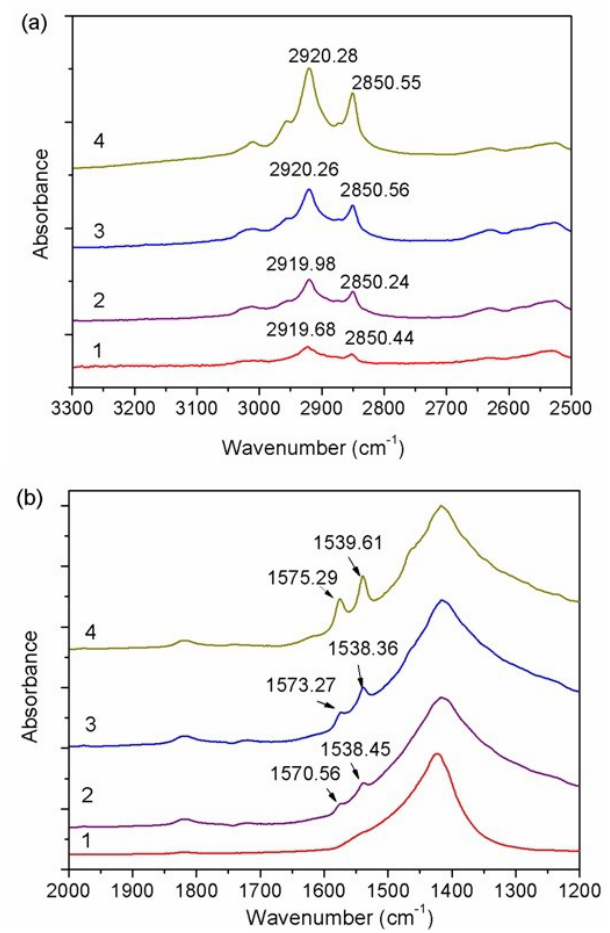
Figure 10. FTIR spectra ( a ) 3300–2500 cm −1 ; ( b ) 2000–1000 cm −1 of dolomite with 1 × 10 −3 mol/L of H 2 SO 4 and oleate at different concentrations (1—1 × 10 −4 mol/L, 2—2 × 10 −4 mol/L, 3—2.5 × 10 −4 mol/L and 4— 3 × 10 −4